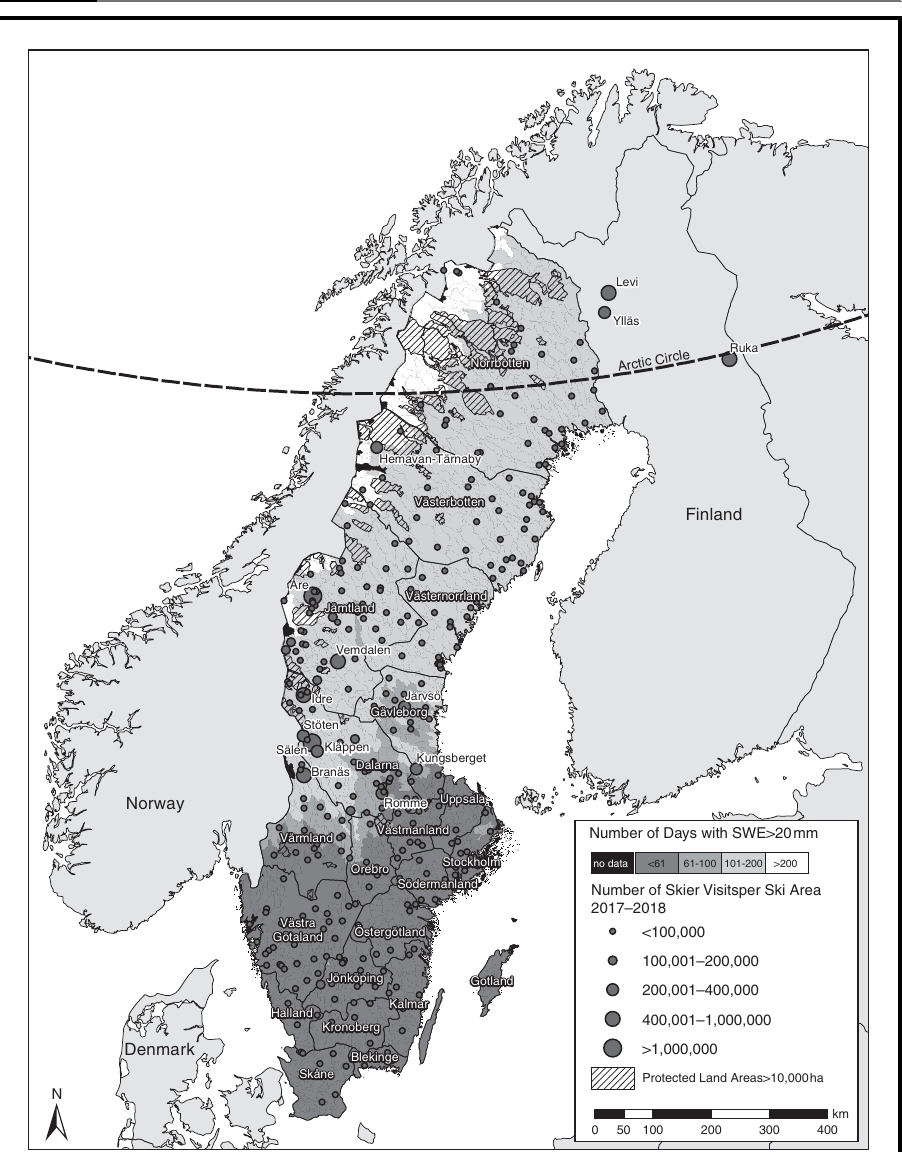
Figure 1 Snow reliability of downhill skiing areas in Sweden 1991 –